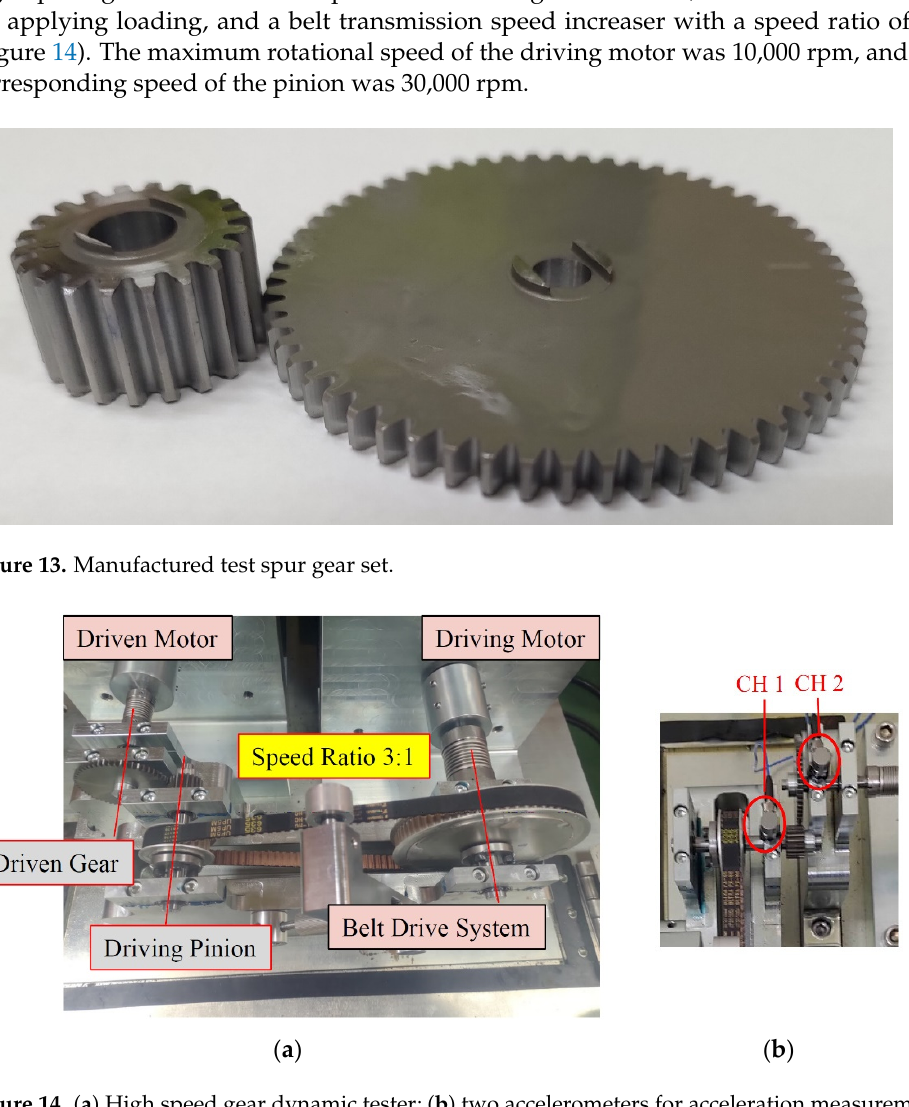
Figure 14. ( a ) High speed gear dynamic tester; ( b ) two accelerometers for acceleration